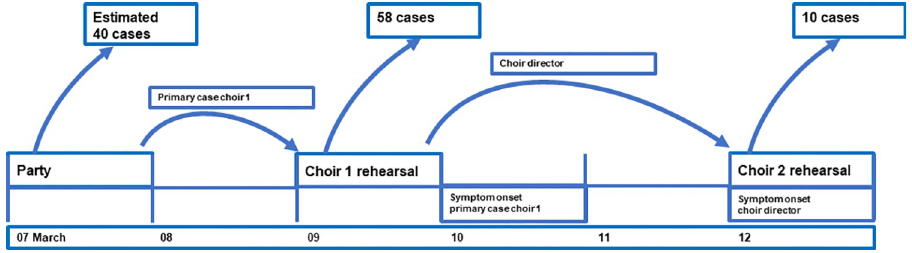
Fig 5. Chronology and number of cases originating from each event, Germany, March